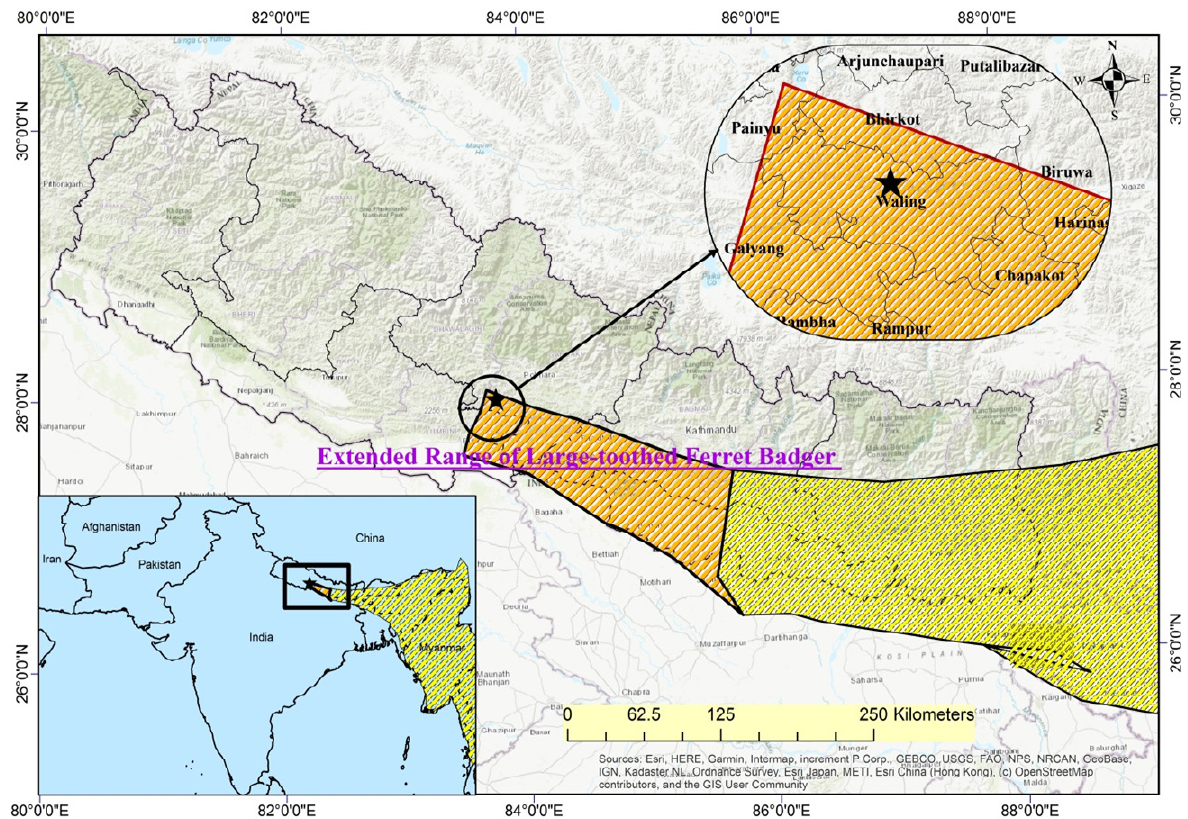
Figure 1. Location of Melogale personata in Waling, Syangja District, Nepal (black star), and current global distribution of the species: yellow = previous range; orange = new range (modified from Duckworth et al.